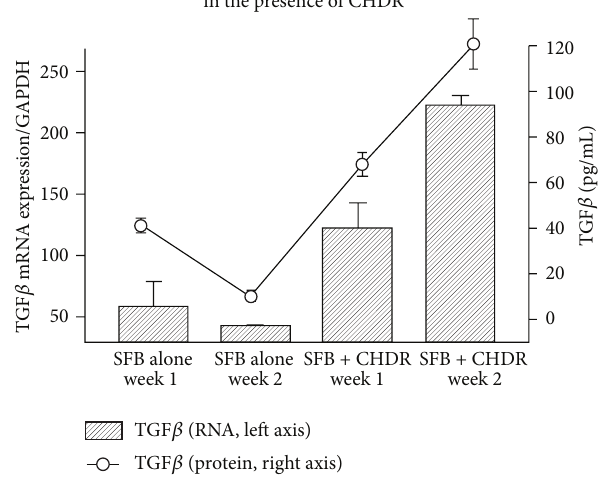
Figure 6: The coculture of SFB with CHDR caused an upregulation of both TGF 𝛽 protein and TGF 𝛽 mRNA ( 𝑝 < 0.05 for both time points) compared to SFB